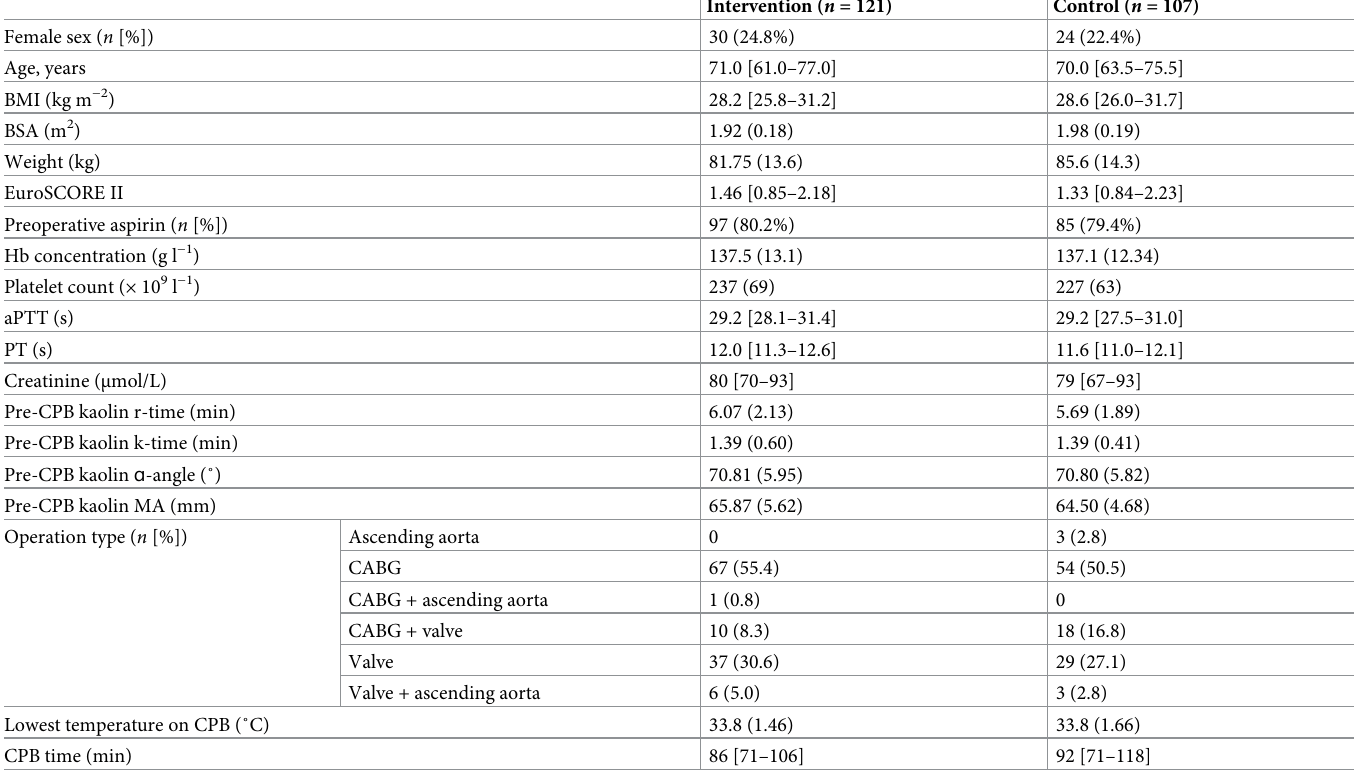
Table 1. Preoperative characteristics and covariates of participants allocated to the intervention (PRODOSE model) and control (fixed 1:1 ratio) groups.